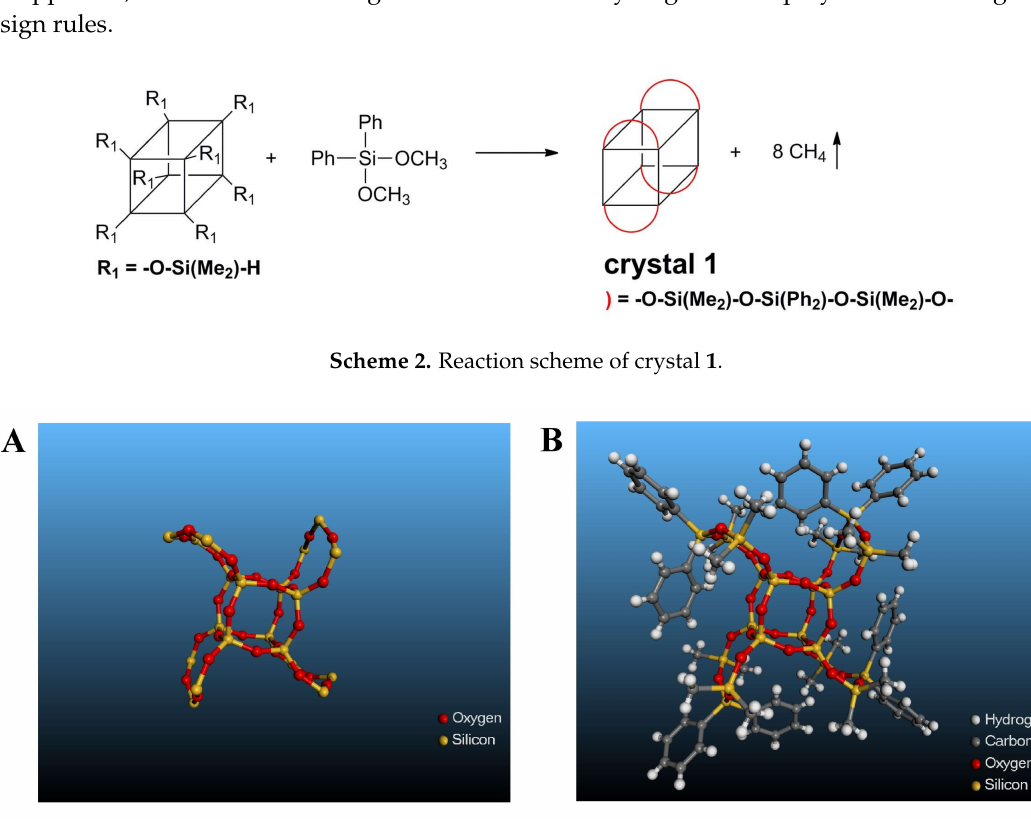
Figure 2. Images of the single crystal structure of crystal 1 without ( A ) and with ( B ) carbon and hydrogen